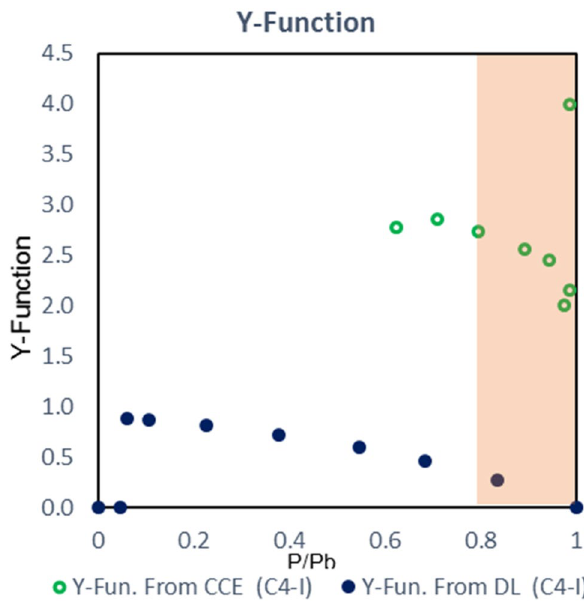
Fig. 24 Invalid trend of Y-function of DL test—(A5-F)